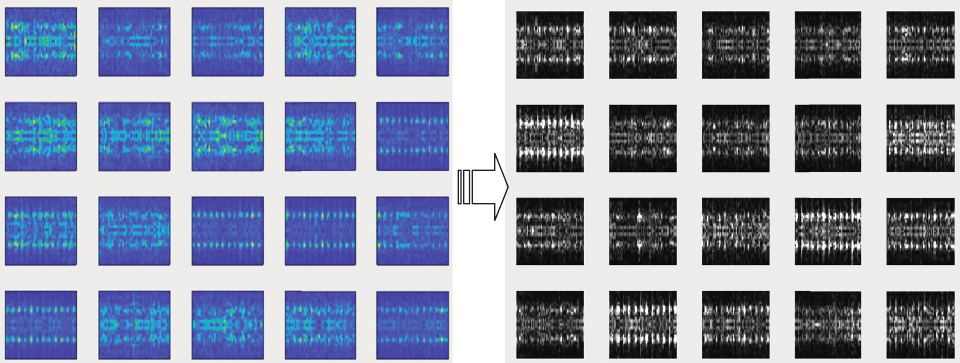
Figure 5: Partial time-frequency maps.